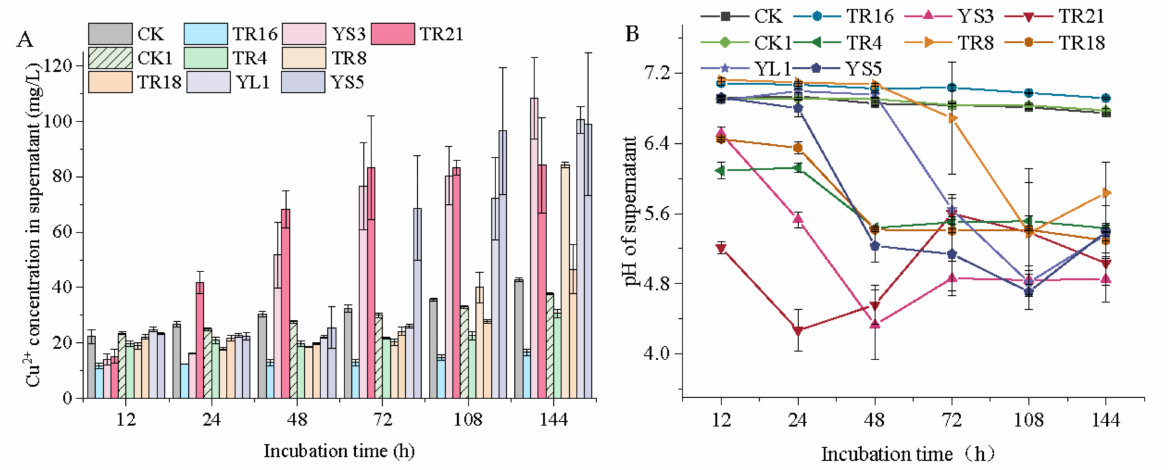
Figure 2. Cu mobilization and variances of pH values in supernatant. ( A ) Cu 2+ concentration in supernatant; ( B ) pH of supernatant.